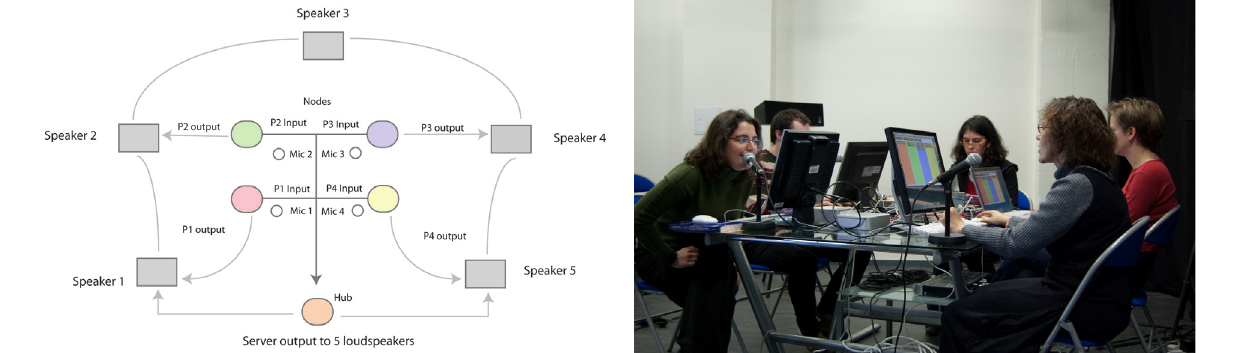
4 | Fig. 4. Topology. P: Participant; Mic: Microphone. 5 | Fig. 5. Participants improvising in